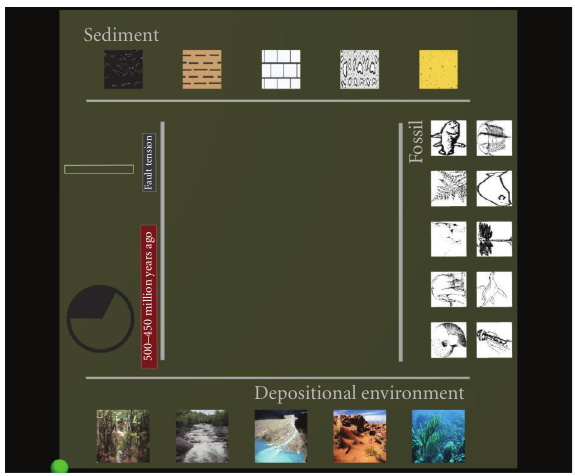
Figure 3: Screen capture of projected layer-cake builder